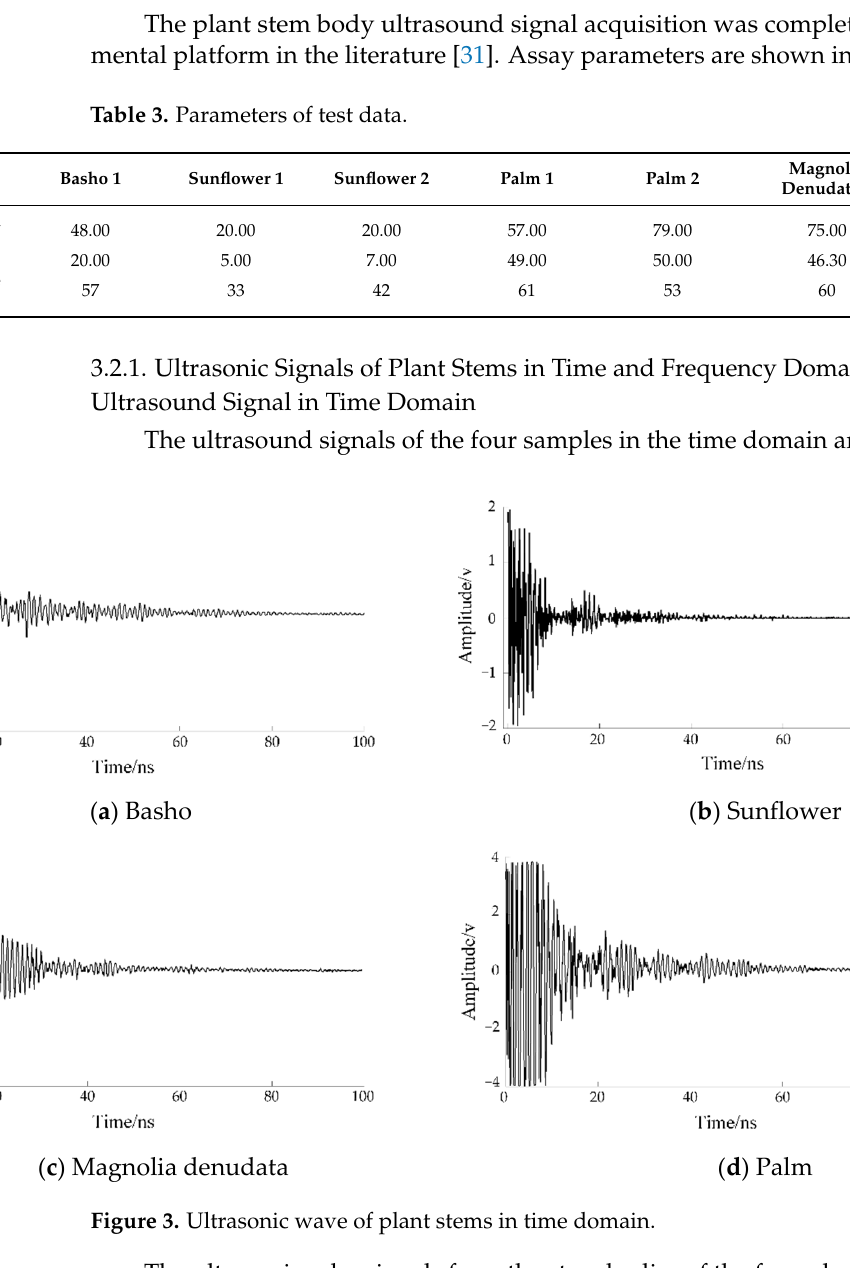
Table 3. Parameters of test data.